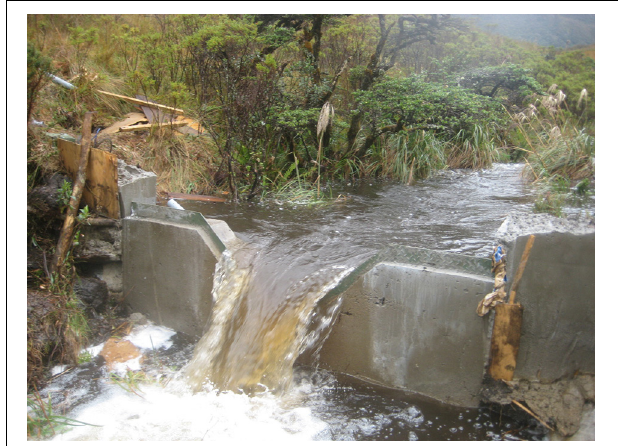
FIGURE 2 | V-notch weir for river flow measurements installed as part of the iMHEA monitoring network in the Peruvian